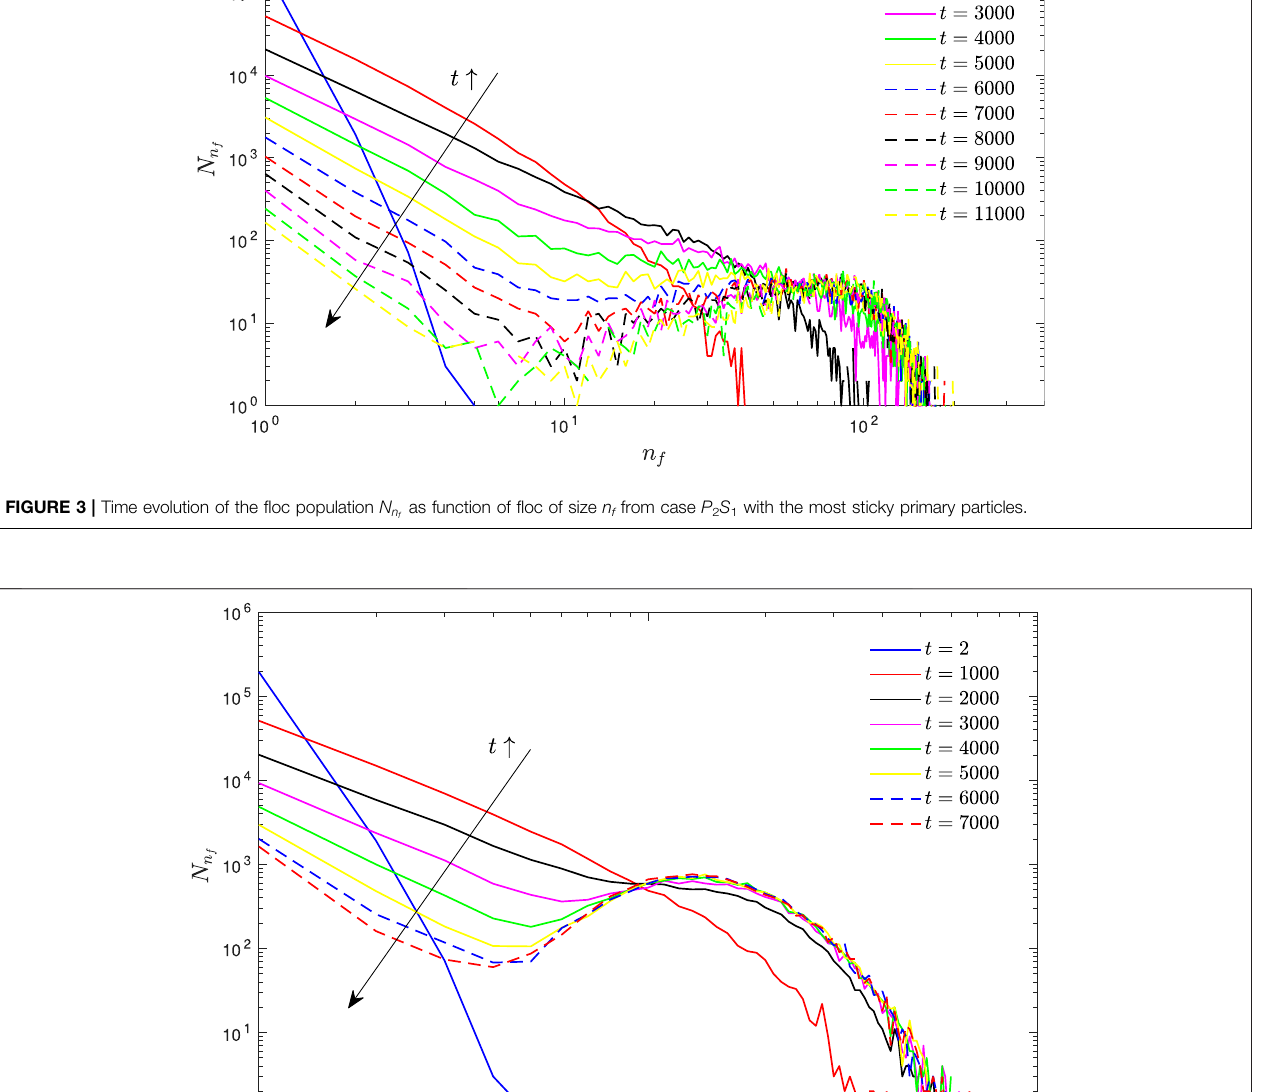
as function of fl oc of size n f from case P 2 S 2 with less sticky and more stiff primary particles. f